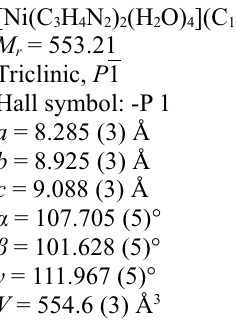
Figure 1 View of the title compound with the atomic numbering and 30% probability displacement ellipsoids [symmetry codes: (A) - x + 1, - y + 1, - z + 1; (B) - x + 1, - y , - z + 2]. Tetraaquadiimidazolenickel(II) naphthalene-1,5-disulfonate Crystal